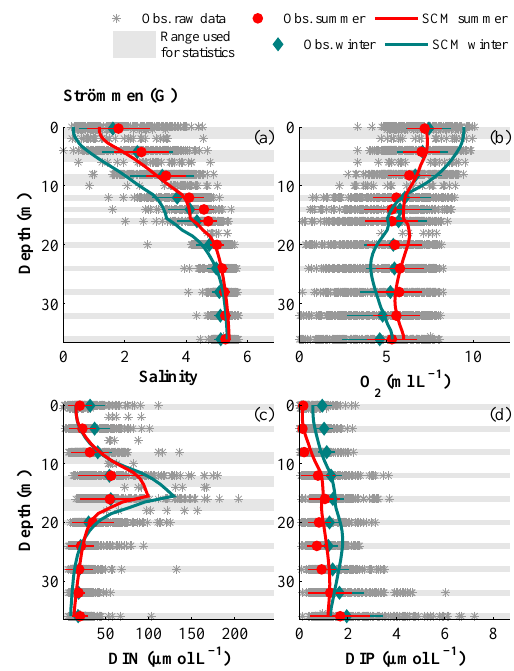
Figure 7. The SCM modelled (lines) and observed (circle and dia- mond) vertical average profiles (1990–2012) of salinity (a) and con- centrations of oxygen (O 2 ; b ), DIN (c) and DIP (d) in the basin Strömmen during winter (turquoise) and summer (red) months. Depth layers with dense number of observations (grey asterisks) de- termined the vertical depth intervals (grey shaded area) used in the profile calculations. The standard deviations (horizontal lines) were calculated for the summer and winter values of the